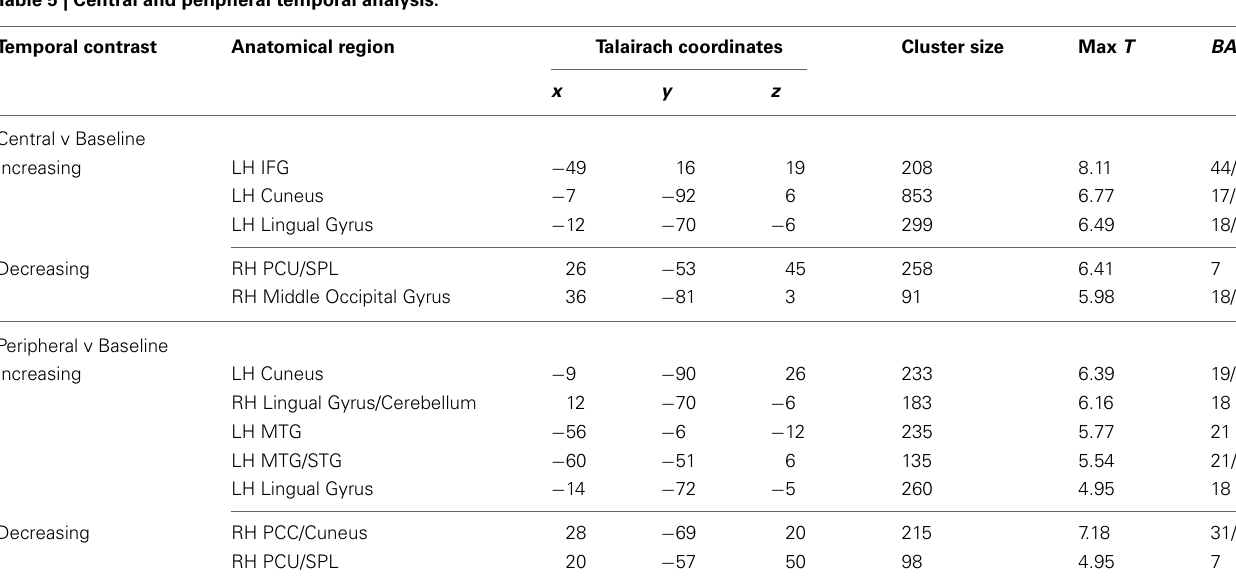
Table 5 | Central and peripheral temporal